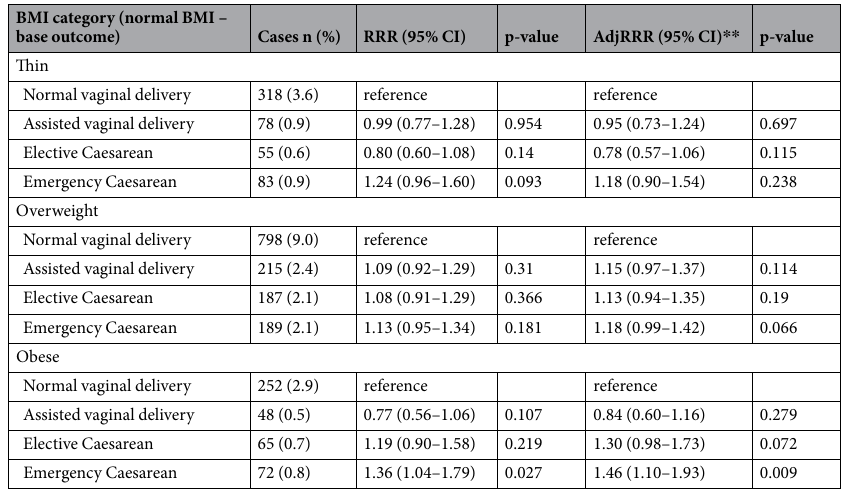
Table 4. Mode of delivery and body mass index at age five years. N for adjusted model = 8819.